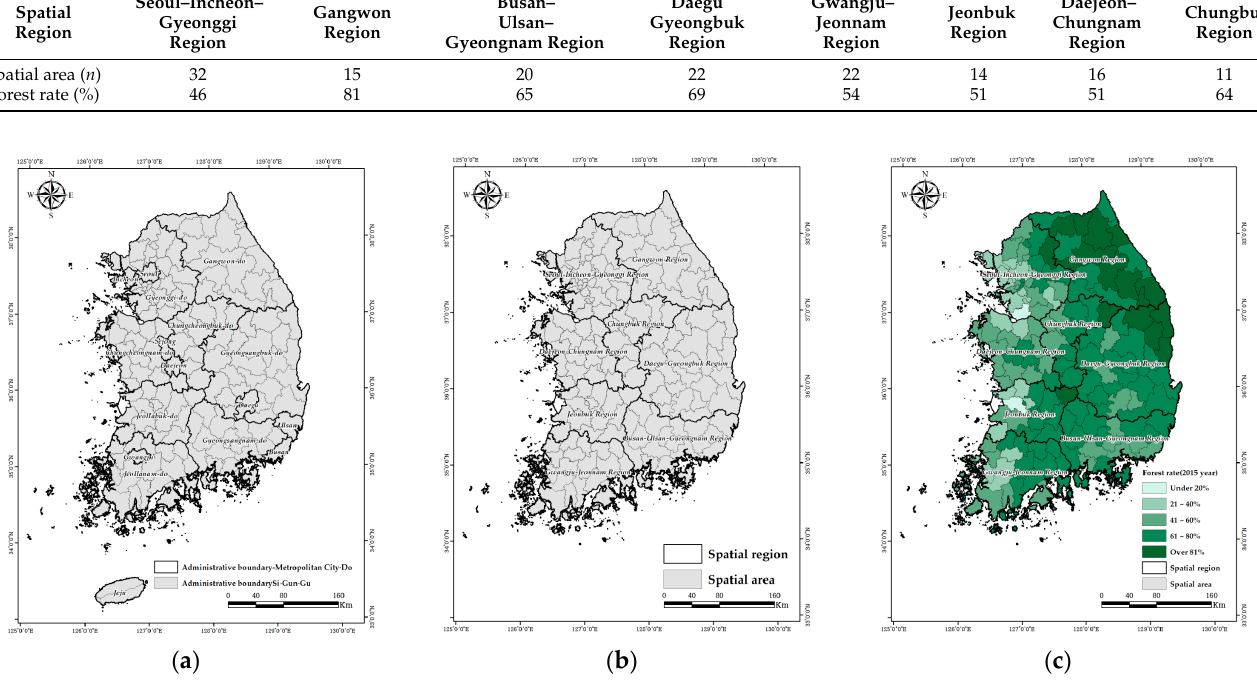
Figure 1. Study area location in South Korea. ( a ) Administrative boundaries at the Metropolitan City·Do level and Si·Gun·Gu level; ( b ) boundaries of spatial regions and spatial areas defined for the study; and ( c ) forest rate in each spatial area in 2015.